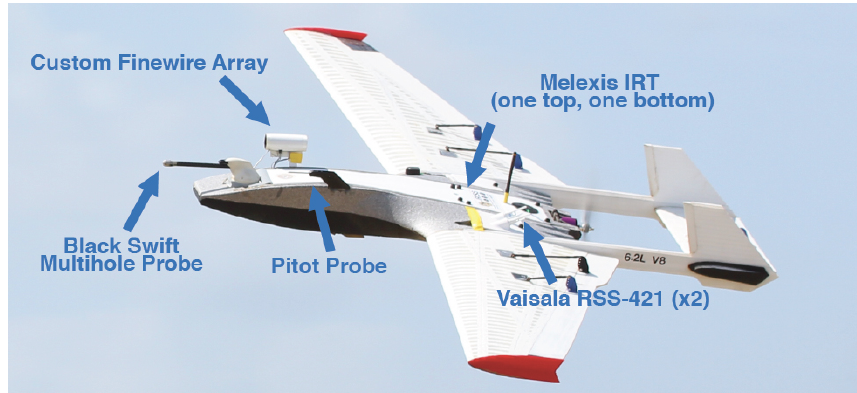
Figure 1. Figure showing a picture of the University of Colorado RAAVEN UAS, as operated in Barbados for ATOMIC, with labels pointing out the locations of the individual